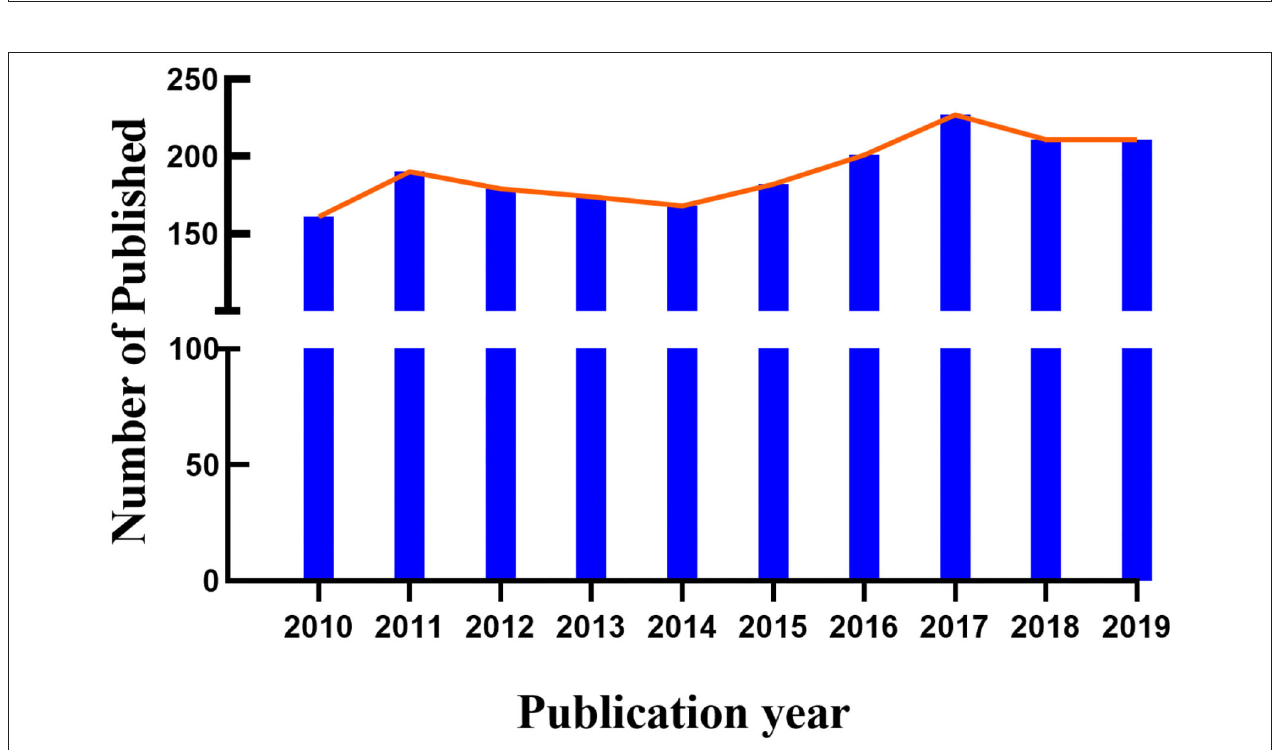
FIGURE 2 | Trends in the number of publications on Cataract-gene from 2010 to 2019.